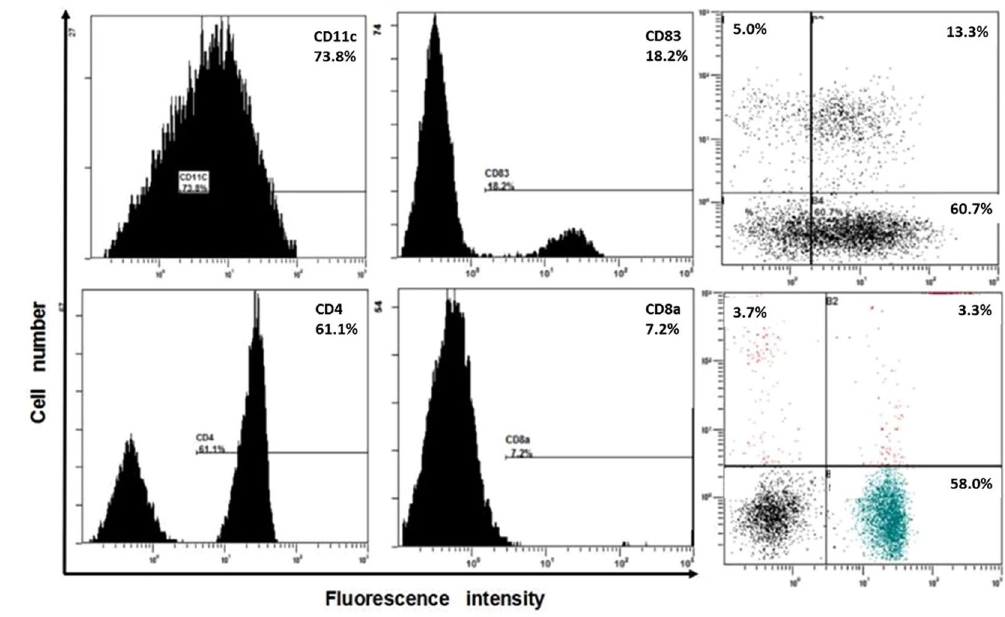
Figure 3. Flow cytometry detection of the phenotypes of DCs and T lymphocytes before